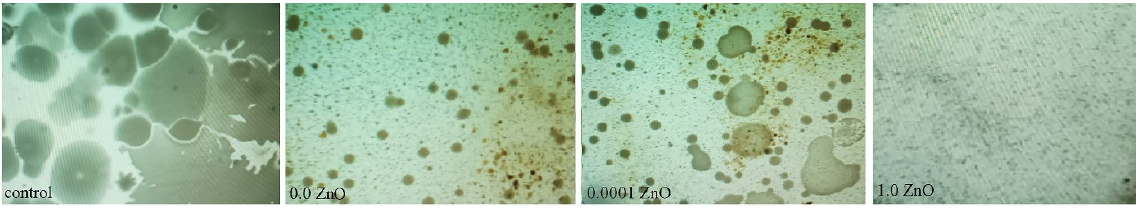
Figure 5. Morphological aspects of colonies growth.